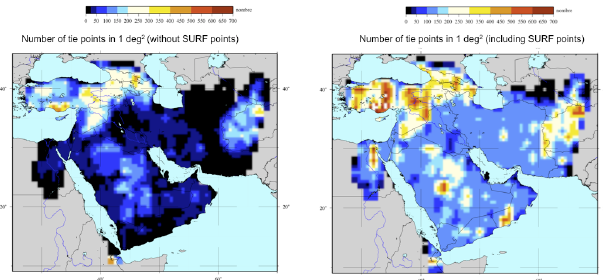
Fig. 2: Density of tie points before (left) and after (right) the introduction of SURF points